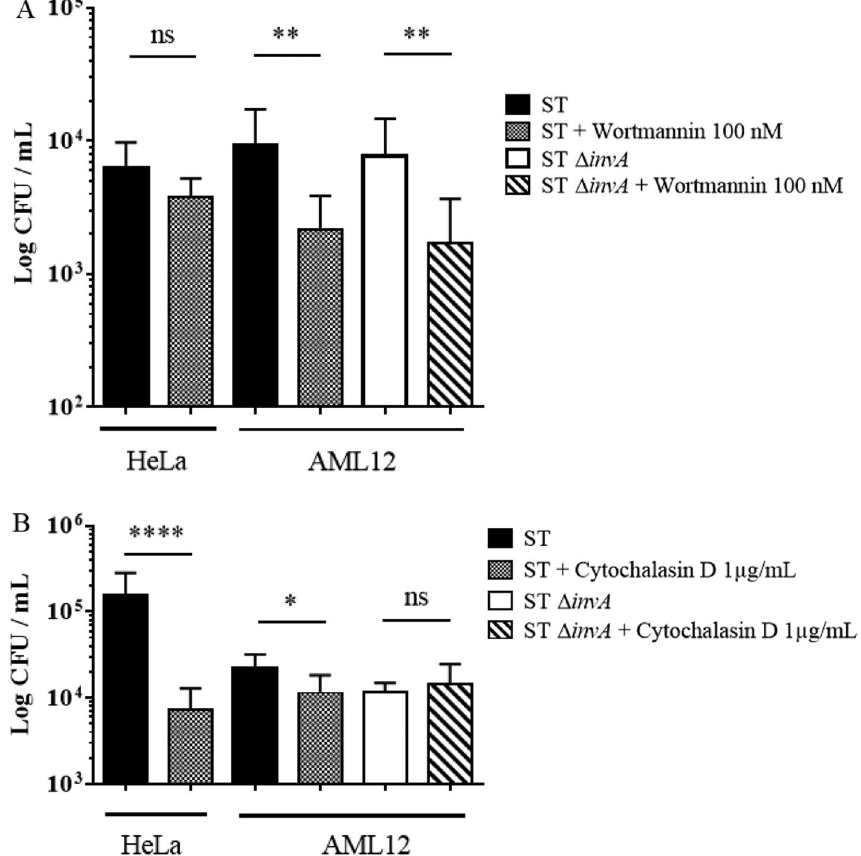
Figure 3. Salmonella Typhimurium entry into AML12 cells was dependent on the PI3 kinase pathway and required weak actin cytoskeletal rearrangements. HeLa cells and AML12 cells were exposed to ( A ) wortmannin (100 nM) (Sigma, St-Louis, MO), a PI3 kinase inhibitor, for 30 min or to ( B ) cytochalasin D (1 µg/mL) for 30 min, followed by an infection and gentamicin protection assay with ST and ST Δ invA . Data are the means and standard deviations from three independent experiments. Statistical analyses using a Mann Whitney test were performed. Significances were (****) p < 0.0001; (**) p < 0.01; (*) p <